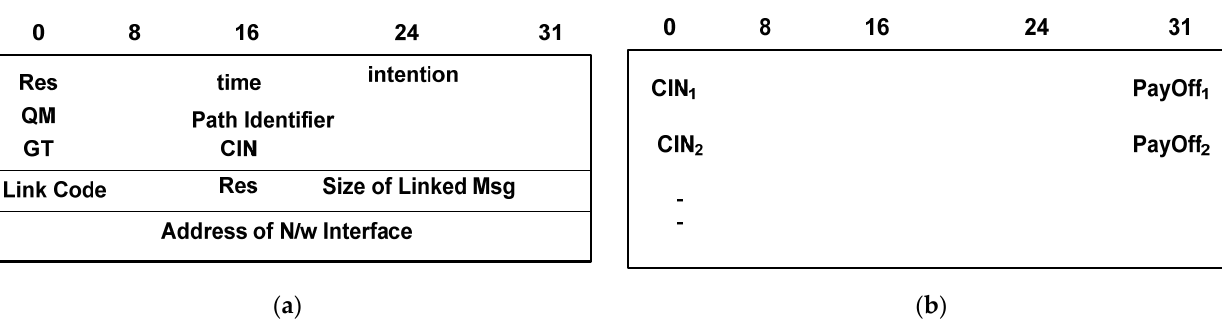
Figure 3. Dependent entities and function of GTC.